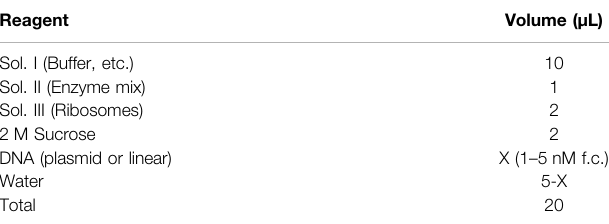
TABLE 2 | Example of the inner solution of arti fi cial cells using the PURE system (PURE frex 2.0).